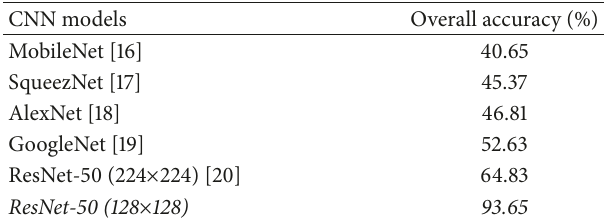
Table 2: Transfer learning results of different CNN model for KDEF